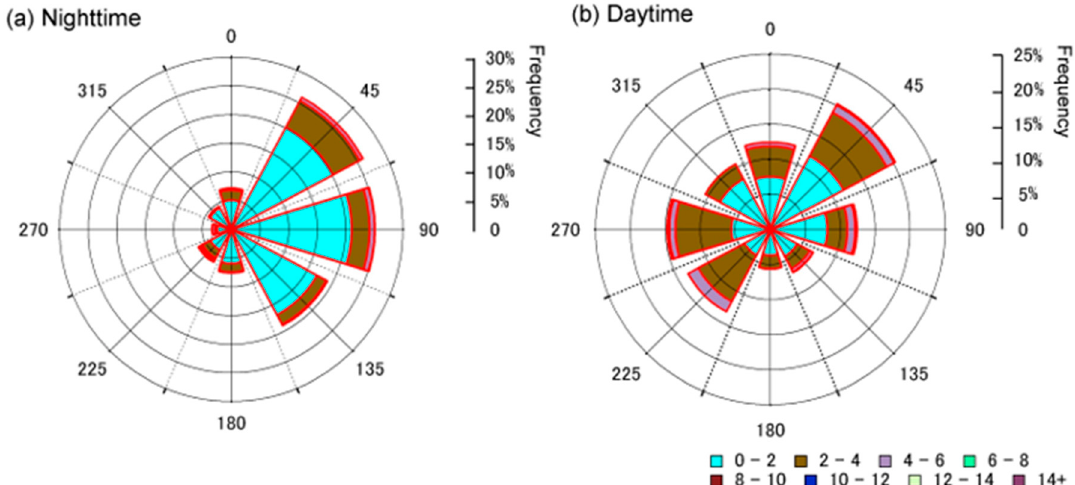
Figure 3. Relative frequency of wind directions at Namie-cho in Fukushima during ( a ) nighttime and ( b ) daytime during the sampling campaign (August to October 2017). Color code labels (0–2, 2–4, etc.) indicate the recorded wind speed in m/s. The meteorological data were obtained from the Japan Meteorological Agency, Tsukuba, Japan.